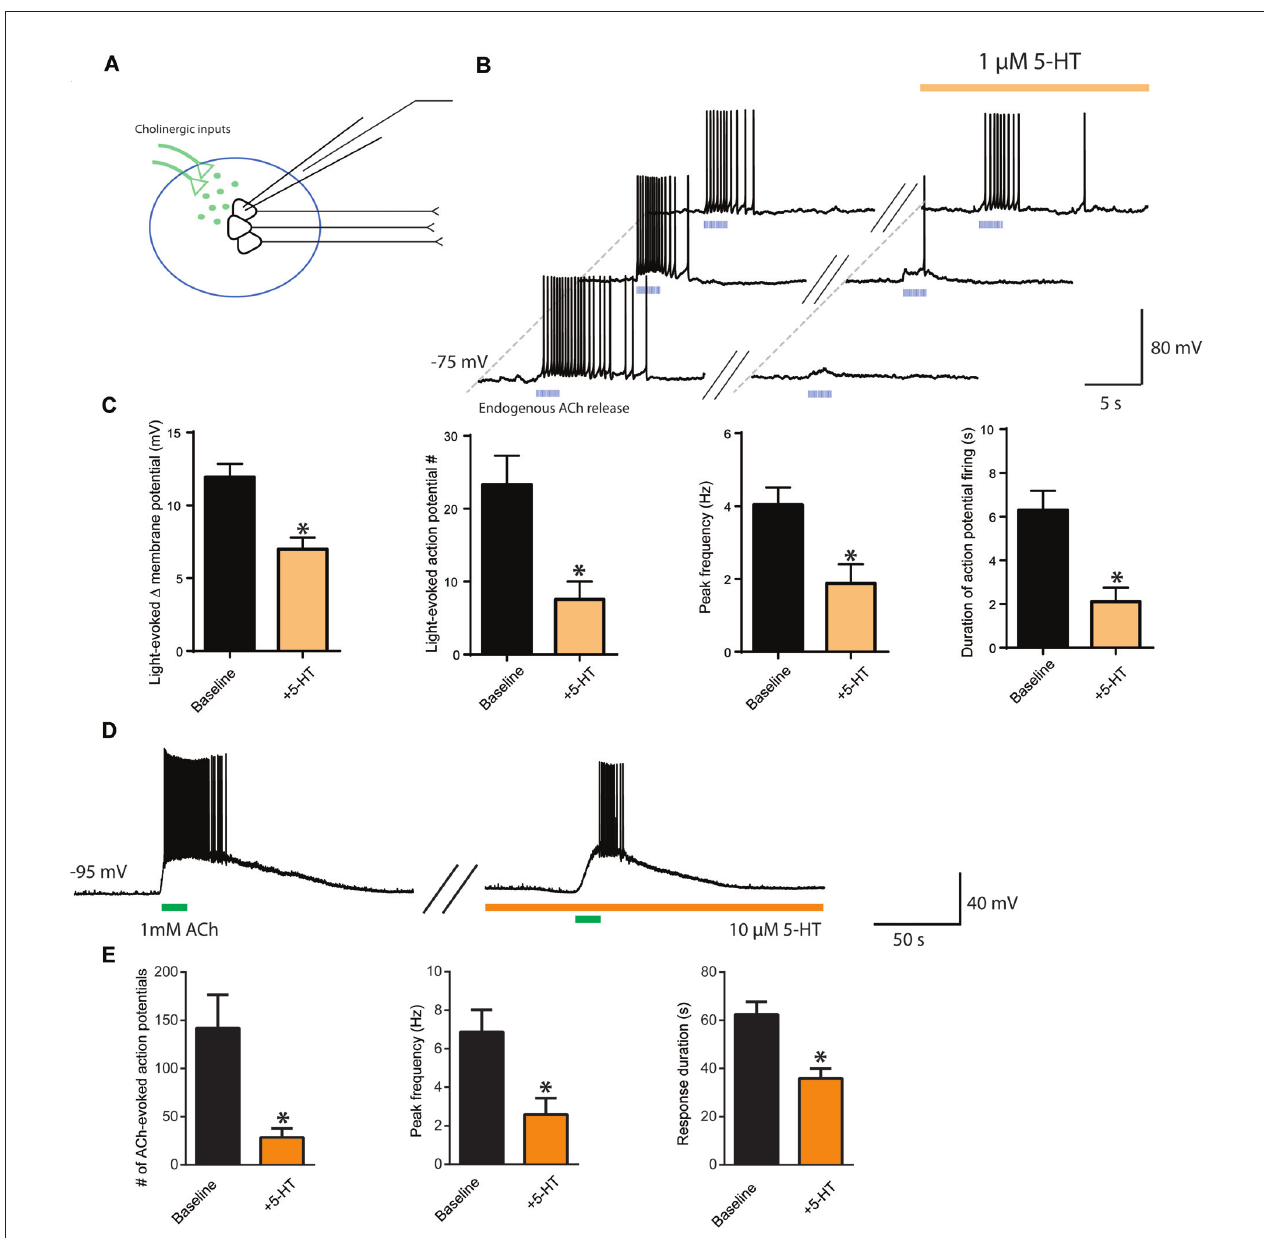
FIGURE 3 | Interaction of cholinergic and serotonergic influences on layer 6 neuronal activity. 5-HT inhibits ACh-induced facilitation of action potential firing. (A) Schematic illustrating light-evoked stimulation of cholinergic fibers synapsing onto layer 6 pyramidal neurons in medial prefrontal cortex. (B) Three different example layer 6 pyramidal neurons demonstrating that the action potential firing evoked by endogenous ACh (5 ms pulses, 10 Hz) is inhibited by application of a low level of exogenous 5-HT (1 µ M). (C) Bar charts show the significant reductions exerted by 5-HT on the following parameters of the layer 6 excitation elicited by optogenetic release of endogenous ACh: change in membrane potential ( t 24 = 4.7, p < 0.0001), number of action potentials ( t 23 = 5.2, p < 0.0001), peak spike frequency ( t 22 = 6.0, p < 0.0001), and duration of action potential firing ( t 24 = 6.3, p < 0.0001). (D) Example neuron showing that the stronger excitation of layer 6 pyramidal neurons through application of exogenous ACh remains susceptible to attenuation by 5-HT. (E) Bar charts show the significant reductions exerted by 5-HT on the following parameters of layer 6 excitation is inhibited by 5-HT: number of action potentials ( t 11 = 4.0, p = 0.0021), peak frequency ( t 11 = 7.4, p < 0.0001) and response duration ( t 12 = 5.27, p = 0.0003). ∗ Denotes p < 0.05. Darker orange indicates a higher concentration of 5-HT (10 µ M), while lighter orange indicates a lower concentration of 5-HT (1 µ